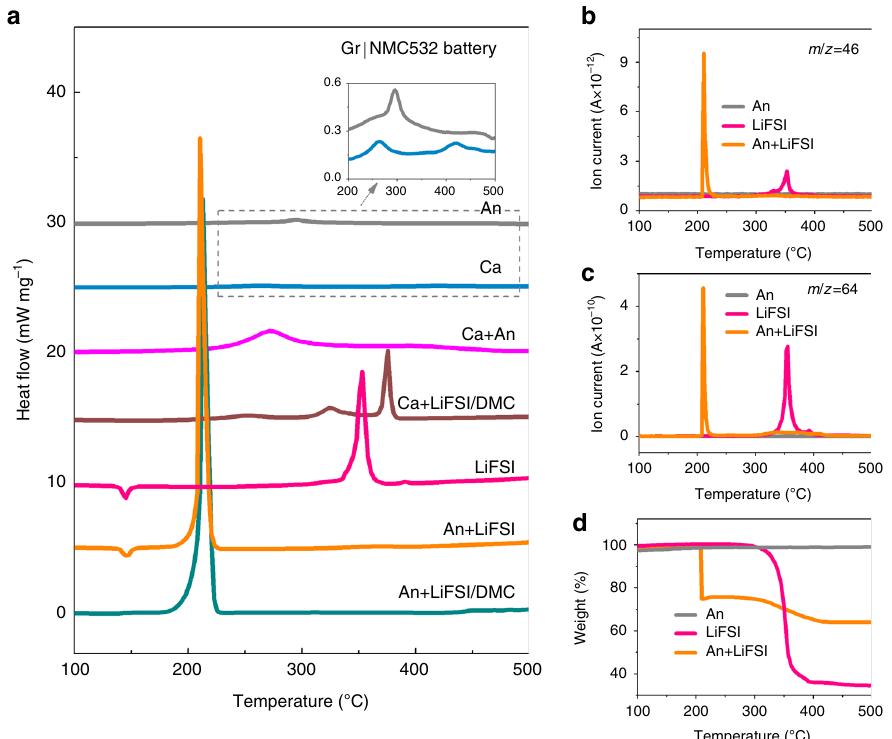
Fig. 5 Thermal stability of cell components and their mixtures in the Gr|NMC532 battery. a DSC traces of the lithiated anode, cathode, concentrated LiFSI/DMC electrolyte components, and their mixtures for the Gr|NMC532 battery. The inset displays the enlarged peaks of Ca and An. b NO 2 ( m / z = 46) gas evolution of the lithiated anode, LiFSI, and their mixture during the DSC measurement. c SO 2 ( m / z = 64) gas evolution of the lithiated anode, LiFSI, and their mixture during the DSC measurement. d The weight loss of the lithiated anode, LiFSI, and their